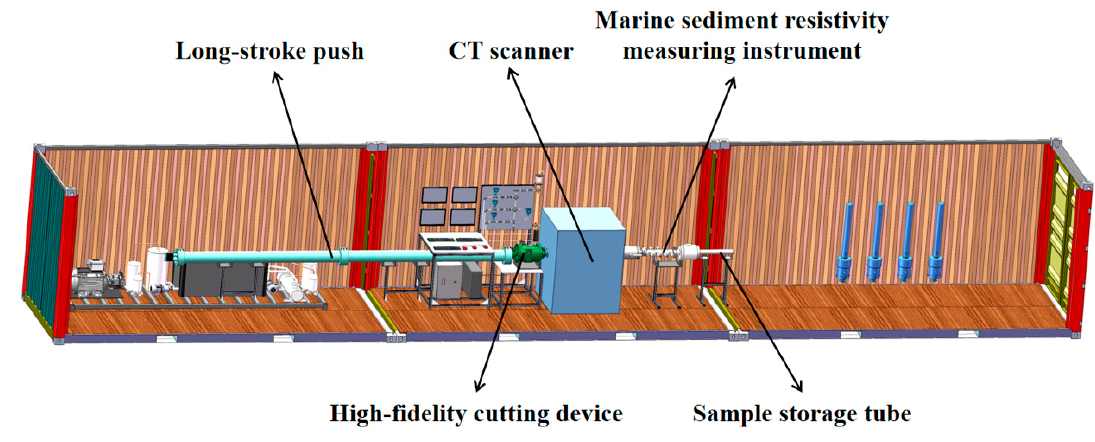
Figure 3. Pressure-maintaining transfer system of the marine sediment resistivity measuring instrument.